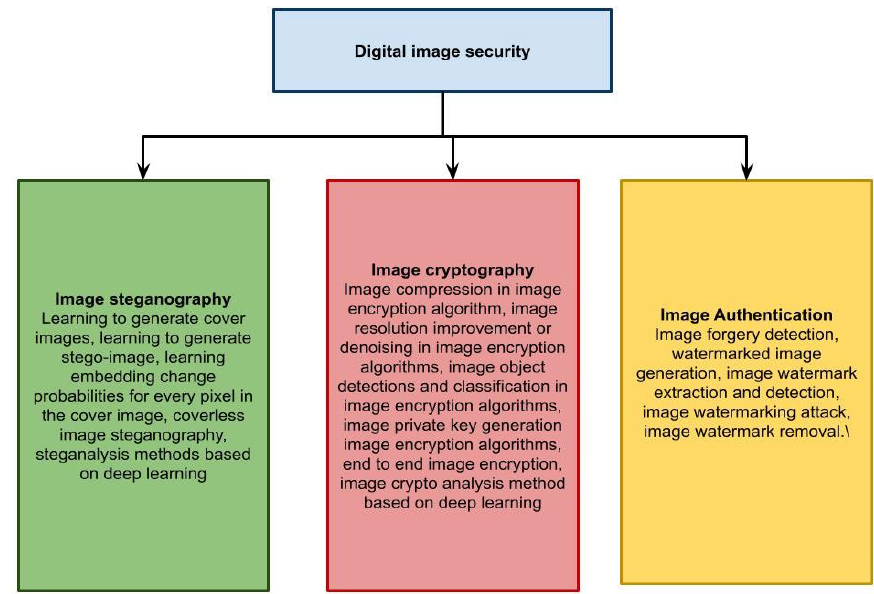
Figure 1. The entire architecture of the digital image security survey.